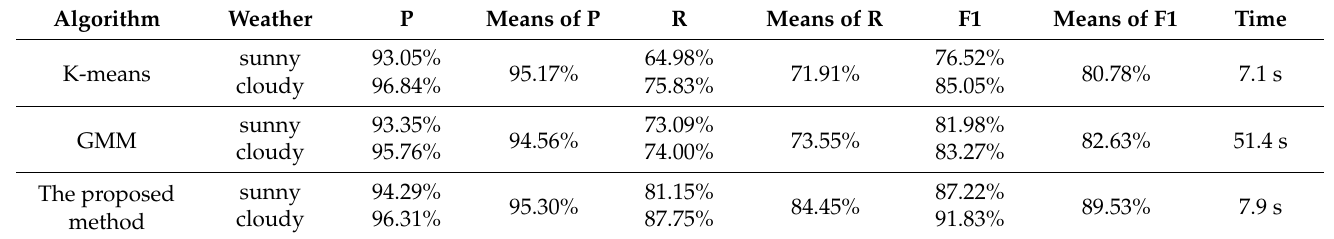
Table 2. Comparison of the evaluation indicators (P, R, F1) of different segmentation